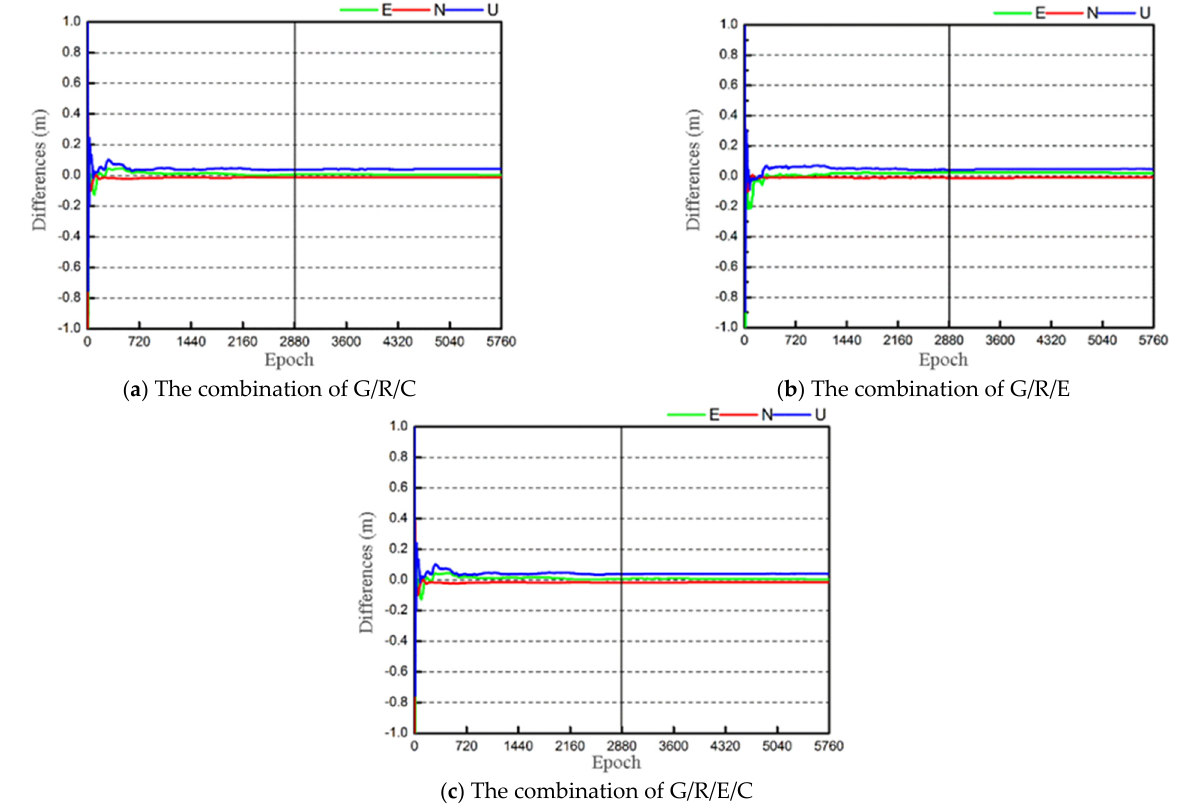
Figure 9. The deviation of splicing solution.